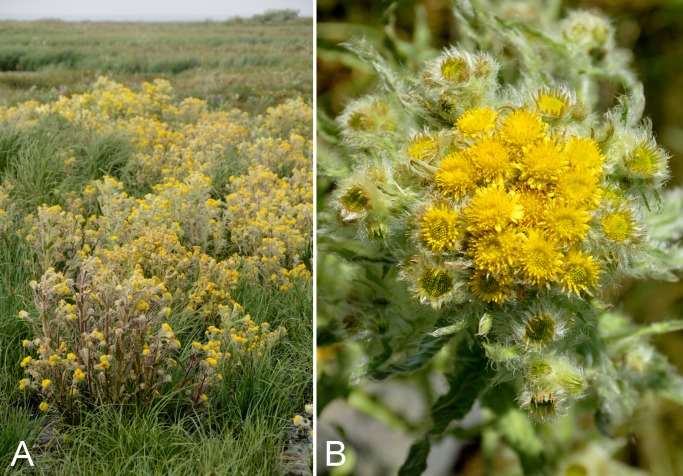
Tephroseris palustris subsp. congesta.(A) Habitat, Kugluktuk, Nunavut, 23 July 2014. (B) Capitula, Saarela et al. 4344. Photographs by R. D. Bull.